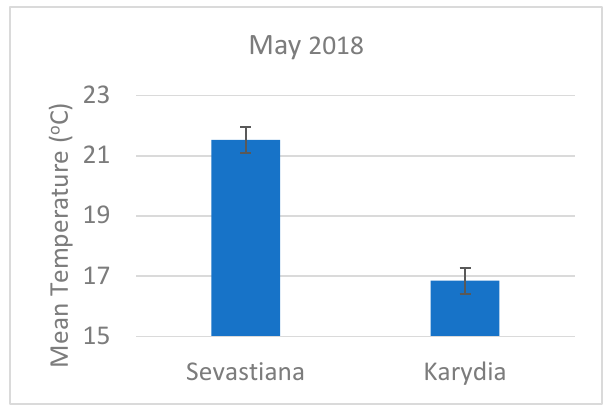
Figure 9. Mean May temperature for Sevastiana and Karydia.